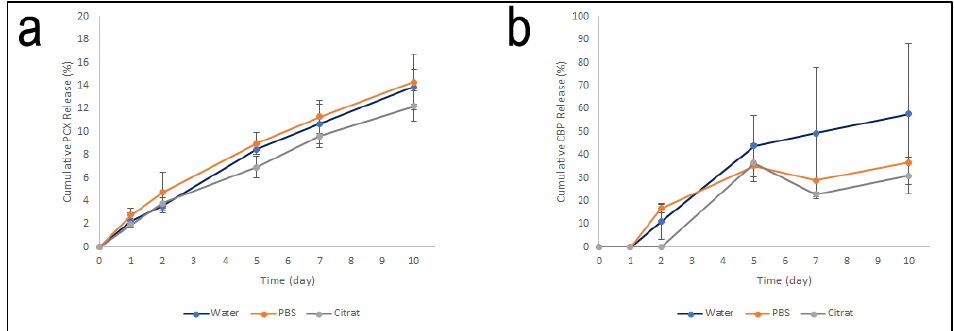
Figure 9. The cumulative drug release profile of ( a ) PCX:CD PCL Filament and ( b ) CBP:CD PCL Filament.